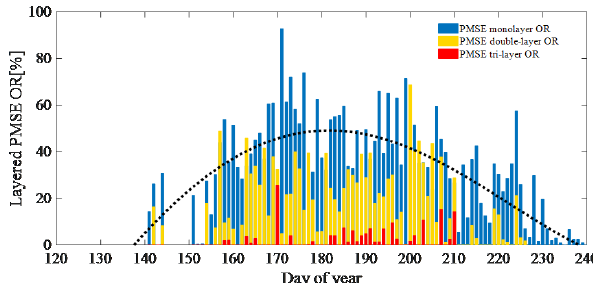
Figure 3. Mean seasonal variation of the mono- (in blue), double- (in yellow), and tri-layer (in red) PMSE occurrence ratio from 2004 to